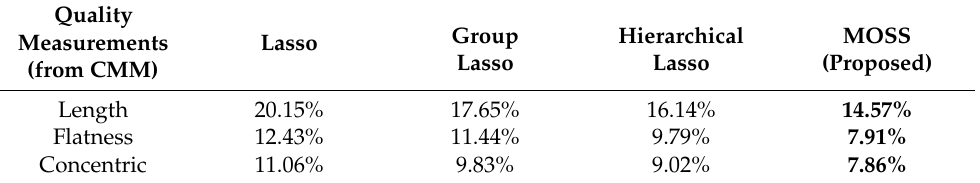
Table 6. Average of Normalized RMSEs.